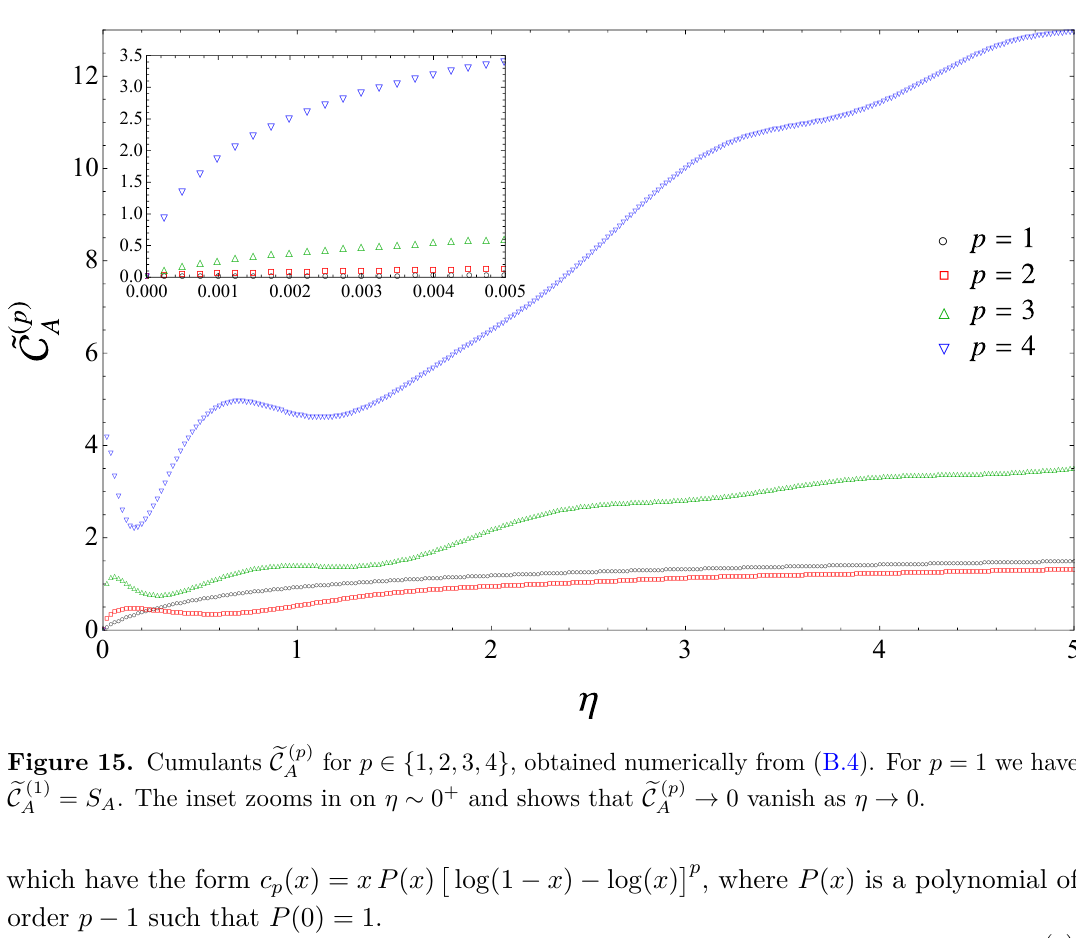
which have the form c ( x ) = x P ( x ) (cid:2) log(1 − x ) − log( x ) (cid:3) p , where P ( x ) is a polynomial of p order p − 1 such that P (0) = 1